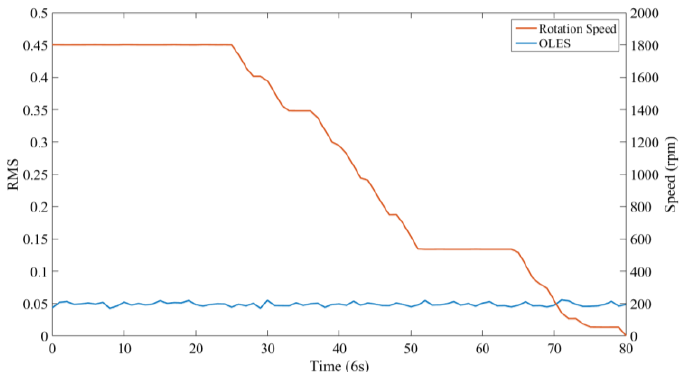
Figure 17. The relationship between the electrostatic signal and the gearbox rotation speed.